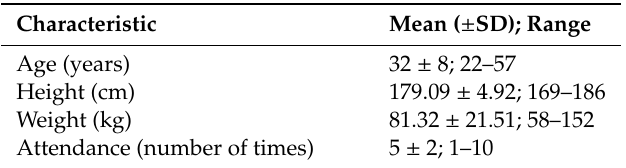
Table 1. Participant